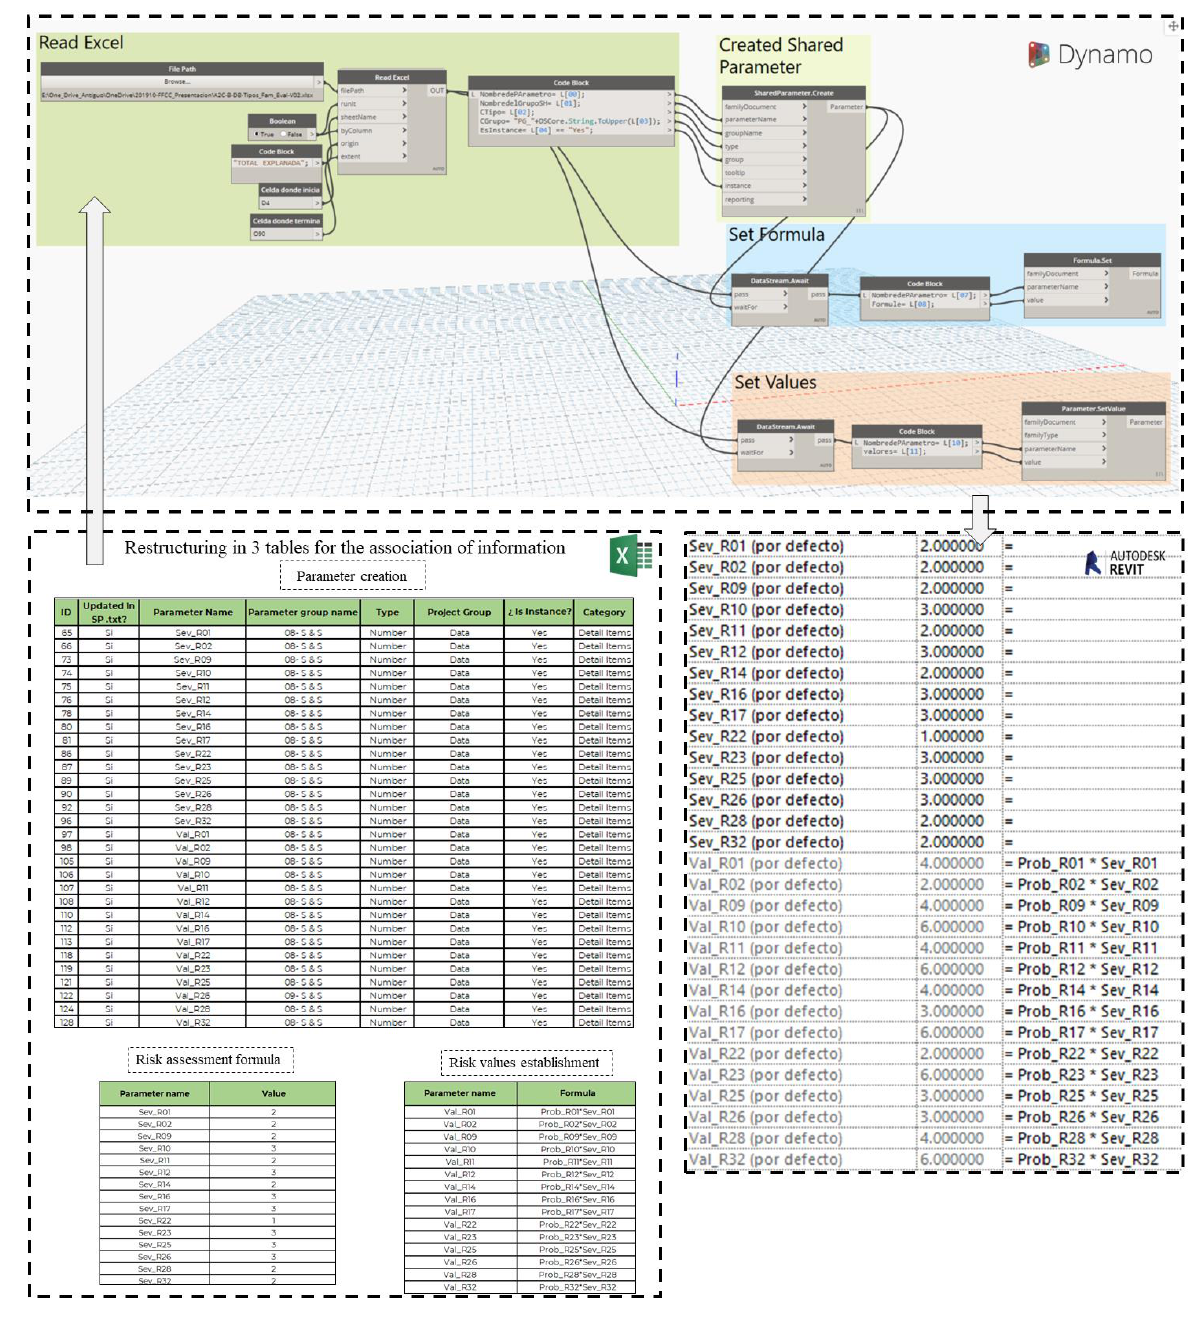
Figure 3. Automation of the introduction of risk information to BIM objects using Dynamo 2.3. The asterisk in the Revit 2020 table is used as the multiplication symbol.